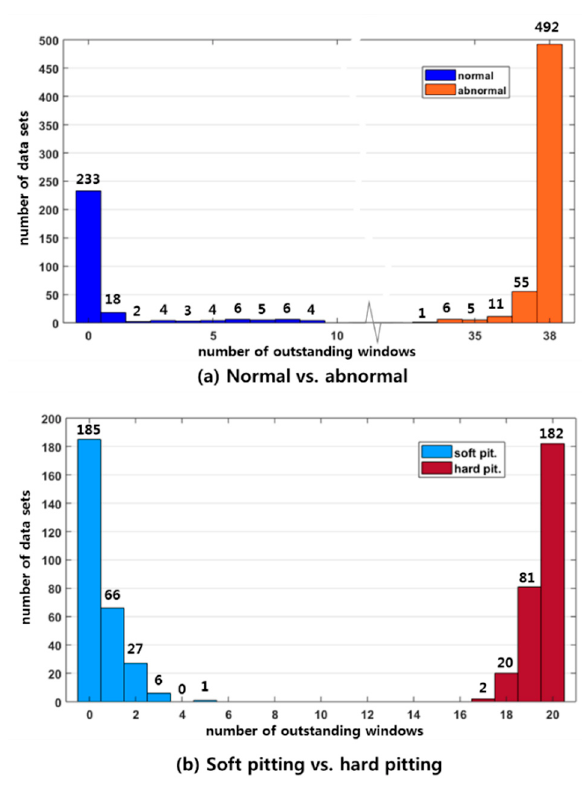
Figure 14. Number of OWs for classification: ( a ) normal vs. abnormal gears, and ( b ) soft pitting vs. hard pitting.